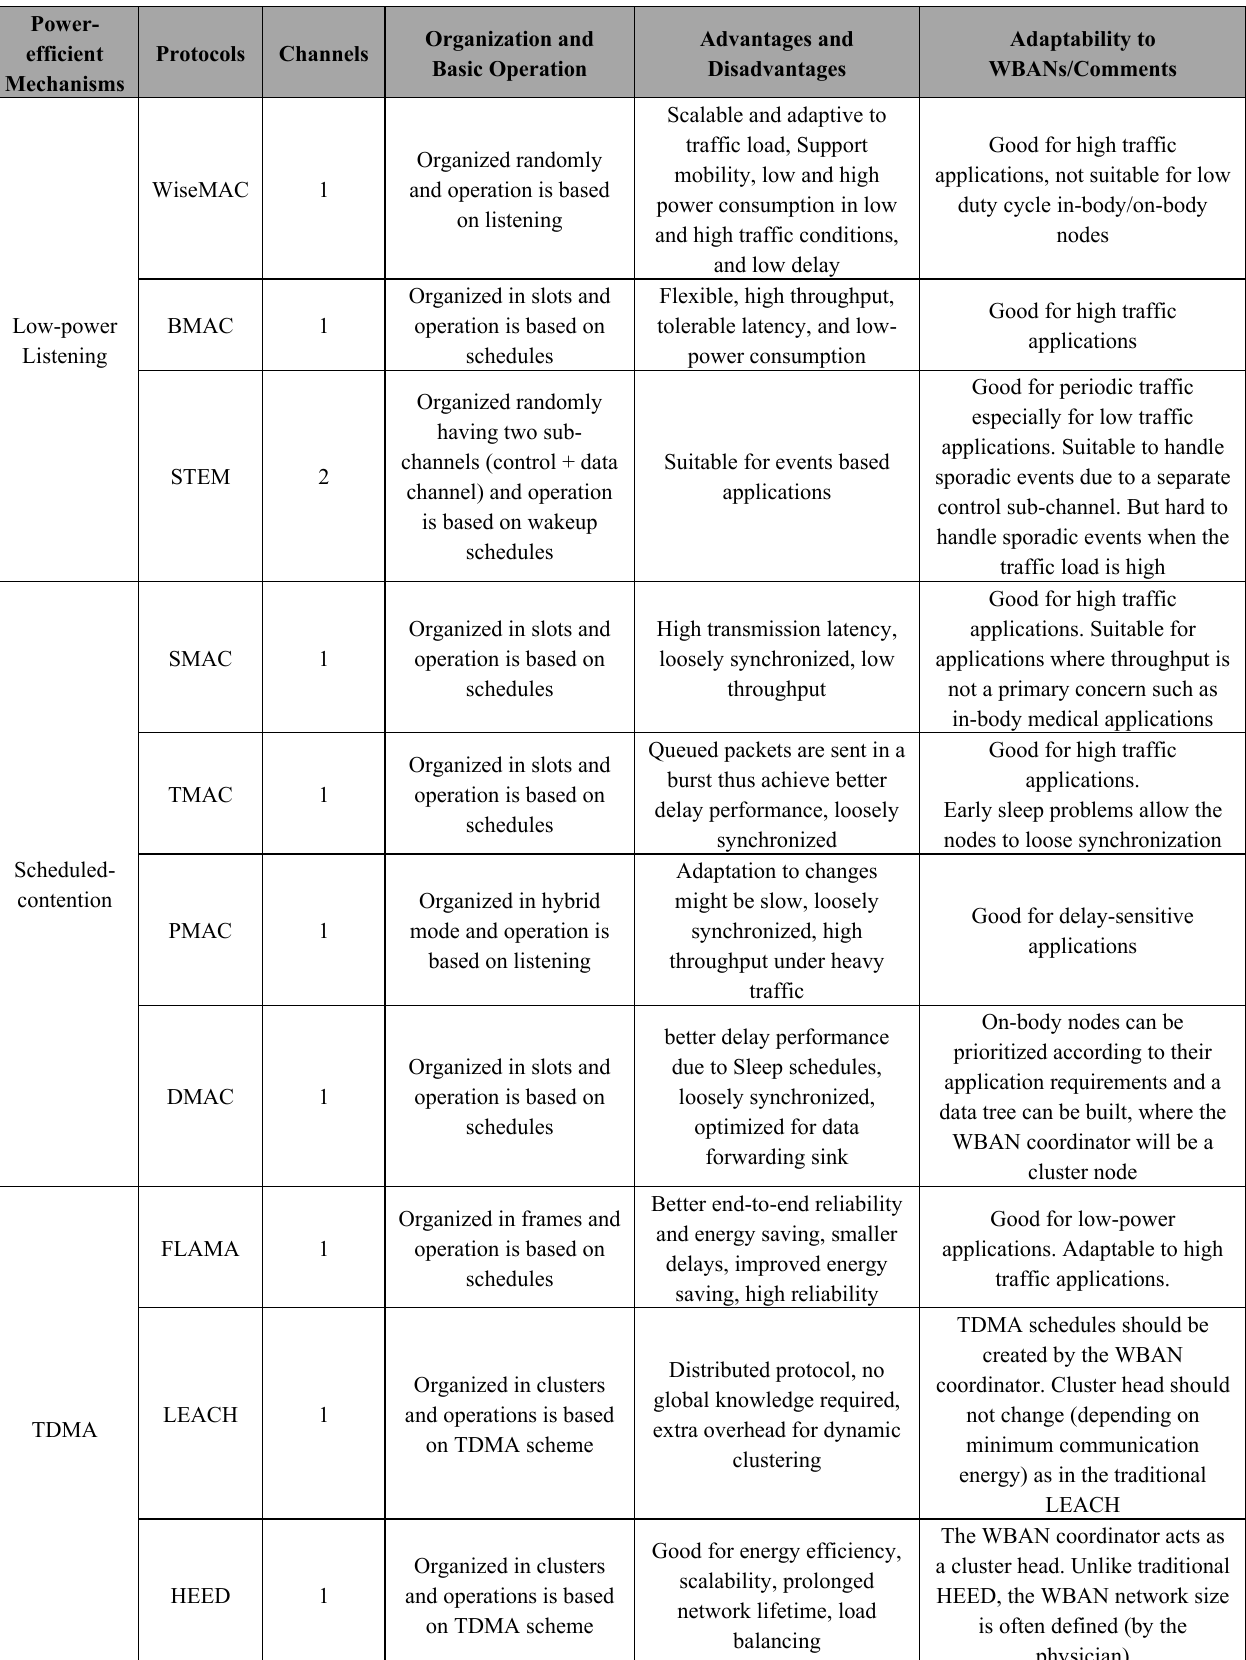
Table 7. Summary of existing MAC Protocols for a